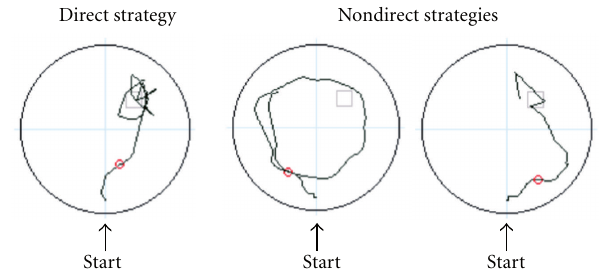
F 2: Sample strategies used by participants during the WMT Probe trial. For the direct strategy (le), participants navigated directly to the platform, and for the nondirect strategy (right), participants navigated in a circuitous or random route that was not in the direction of the platform